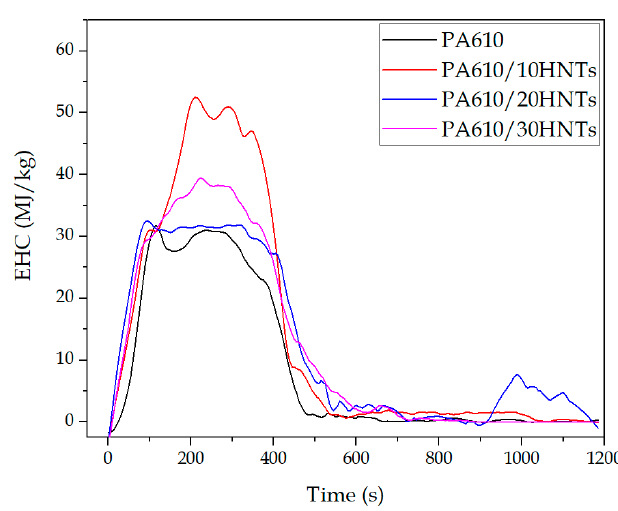
Figure 2. E ff ective heat of combustion as a function of time. Figure 2. Effective heat of combustion as a function of time. Figure 2. Effective heat of combustion as a function of time.